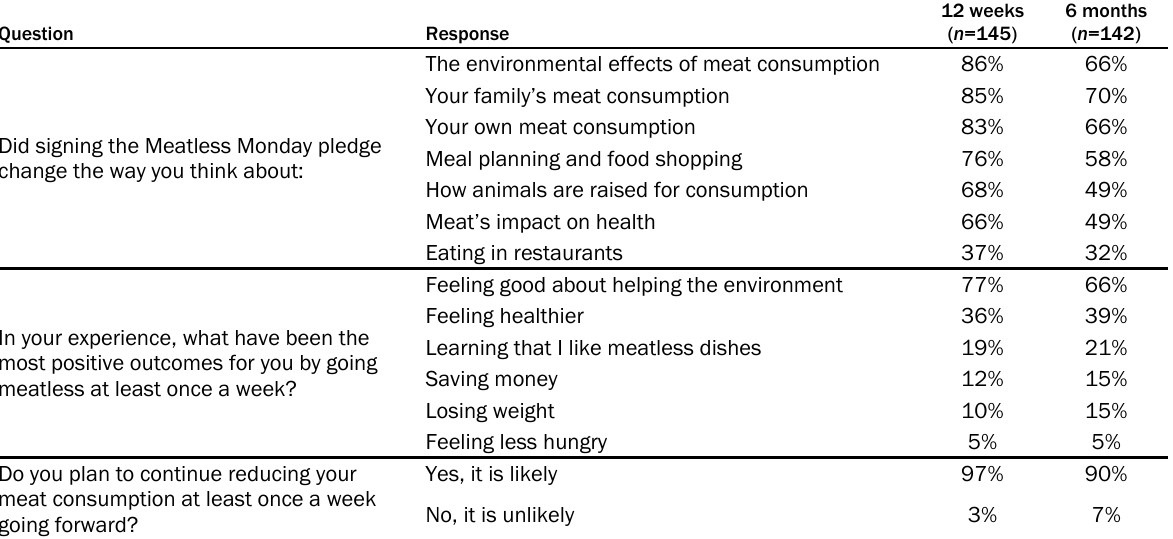
Table 3. Attitudes, Motivations, and Intentions to Reduce Meat Consumption at 12 Weeks and Six- Month Follow